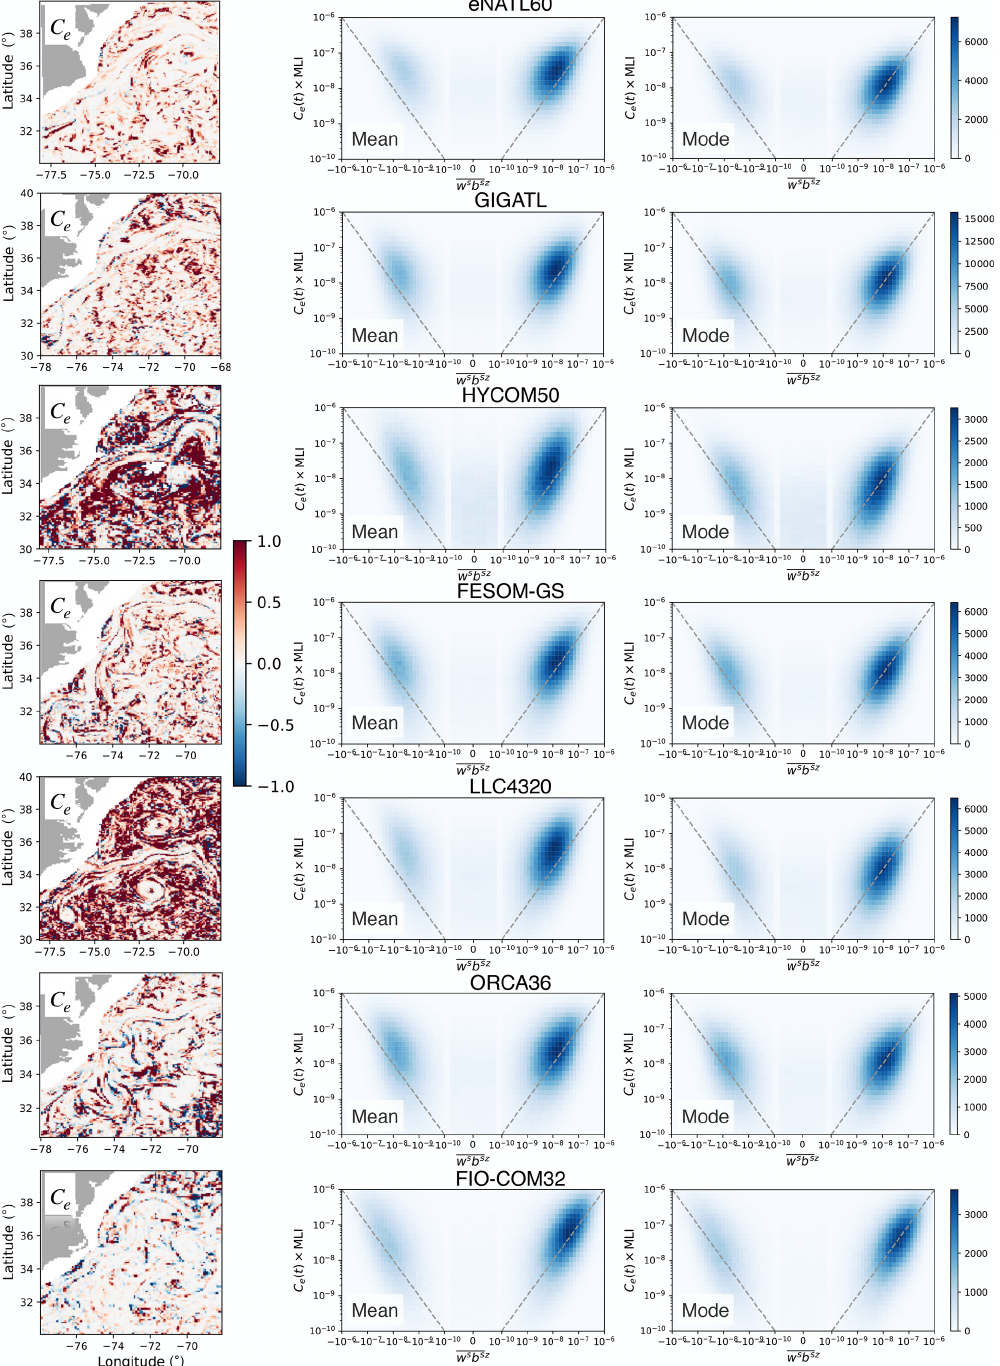
Figure E1. Snapshot of the efficiency coefficient C e (t,x,y) diagnosed on 1 February from each simulation (left column). The joint histogram z (cid:105) of (cid:104) w s b s and C e (t) × MLI during the months of February to April (right columns). The middle column shows the histogram when C e (t) is taken as the spatial mean of C e (t,x,y) and the right column as the spatial mode of C e (t,x,y) . The one-to-one line is shown as the grey dashed